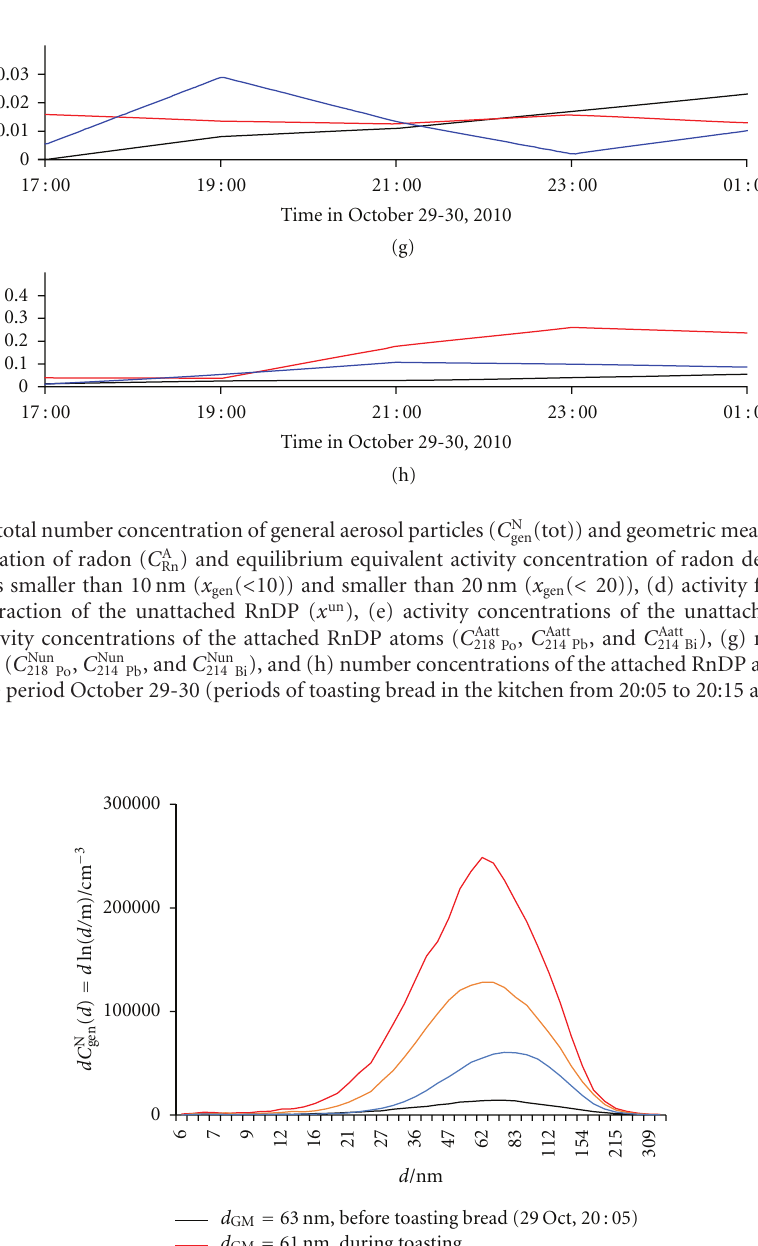
( d ) = dln( d/ m)) of general aerosol particles in indoor air in the kitchen during toasting of